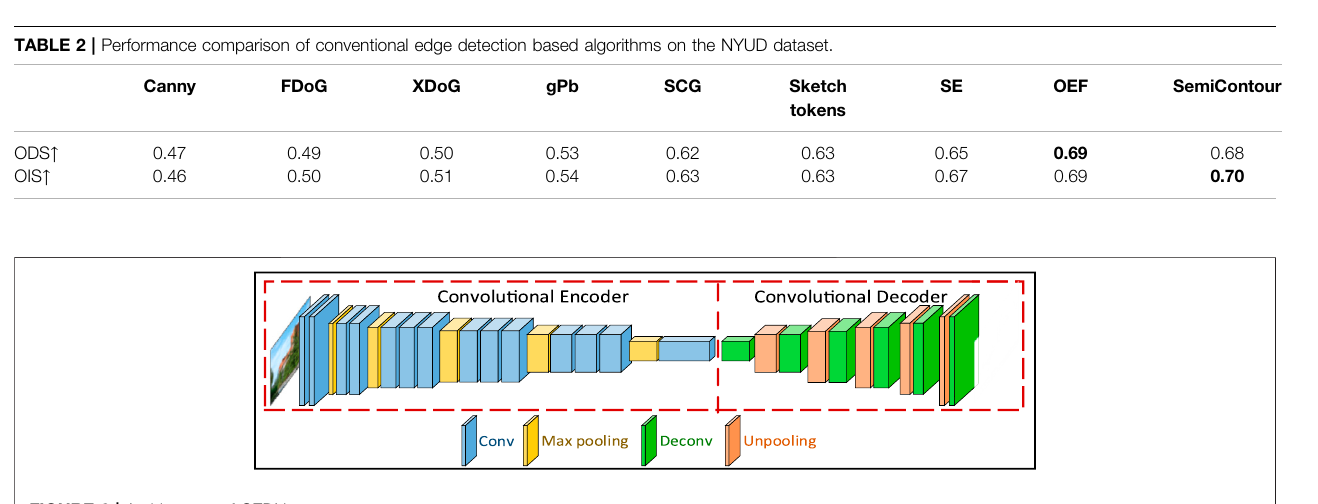
FIGURE 2 | Architecture of